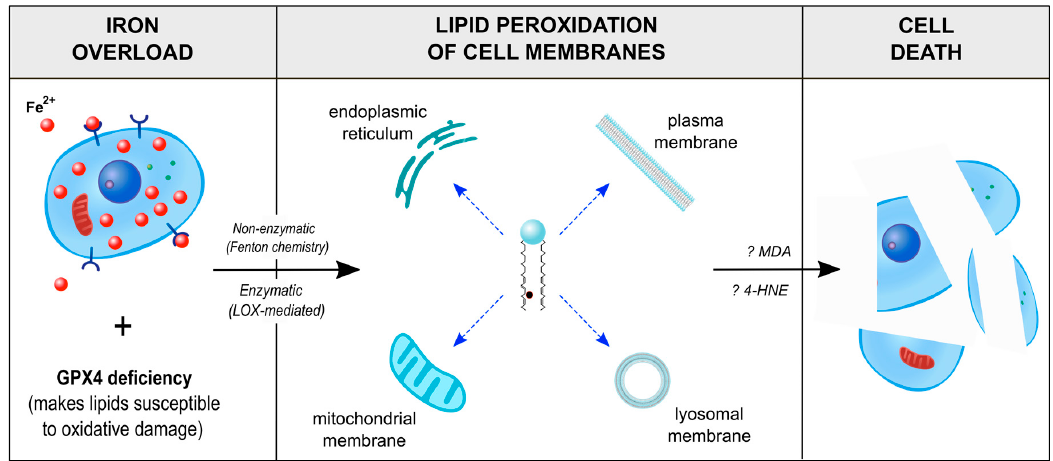
Figure 3. Proposed cellular mechanisms of ferroptosis, which refers to programmed cell death by iron-dependent lipid peroxidation within cell mediated by iron-dependent lipid peroxidation within cell membranes.